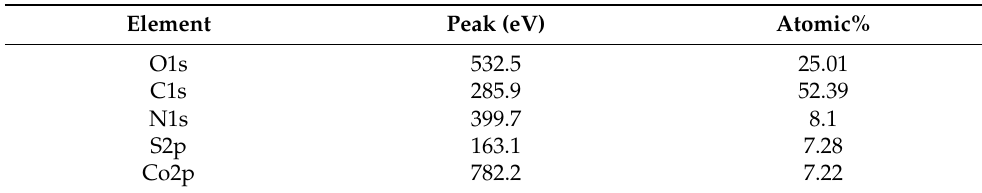
Table 1. The binding energy and percent of elements in the composite CoS-Co 2 O 3 /G-C3N4 were calculated from the XPS analysis.